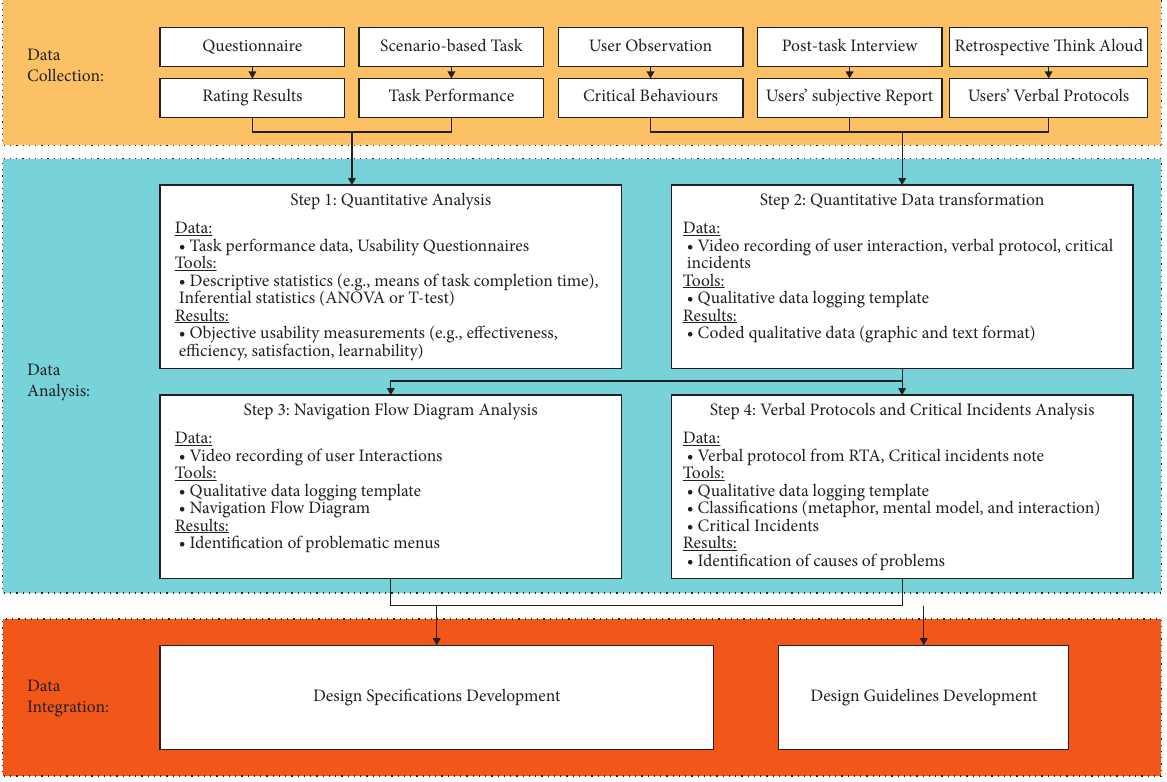
Figure 2: Data mining structure based on clustering algorithm.